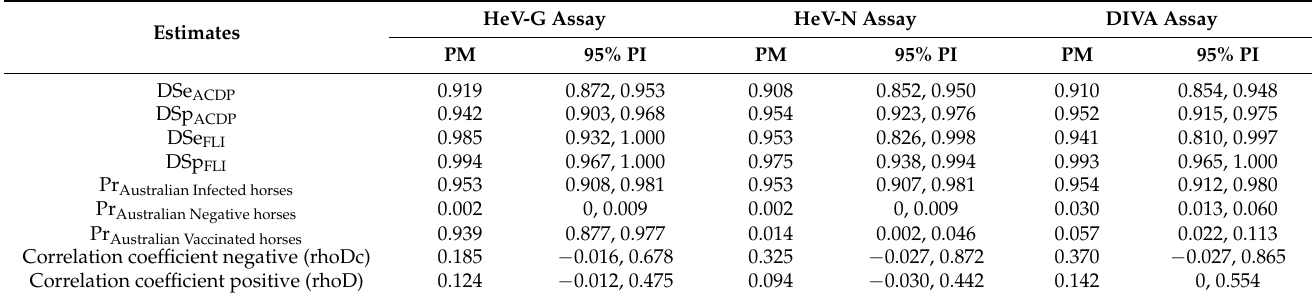
Table 4. Estimates of relative diagnostic sensitivity (DSe) and specificity (DSp), population prevalence and correlation coefficient for negatives and positive results, based on the BLCM for HeV-G, HeV-N, and the DIVA interpretations based on the two assays. (Pr—prevalence; PM—posterior median; 95% PI—95% posterior